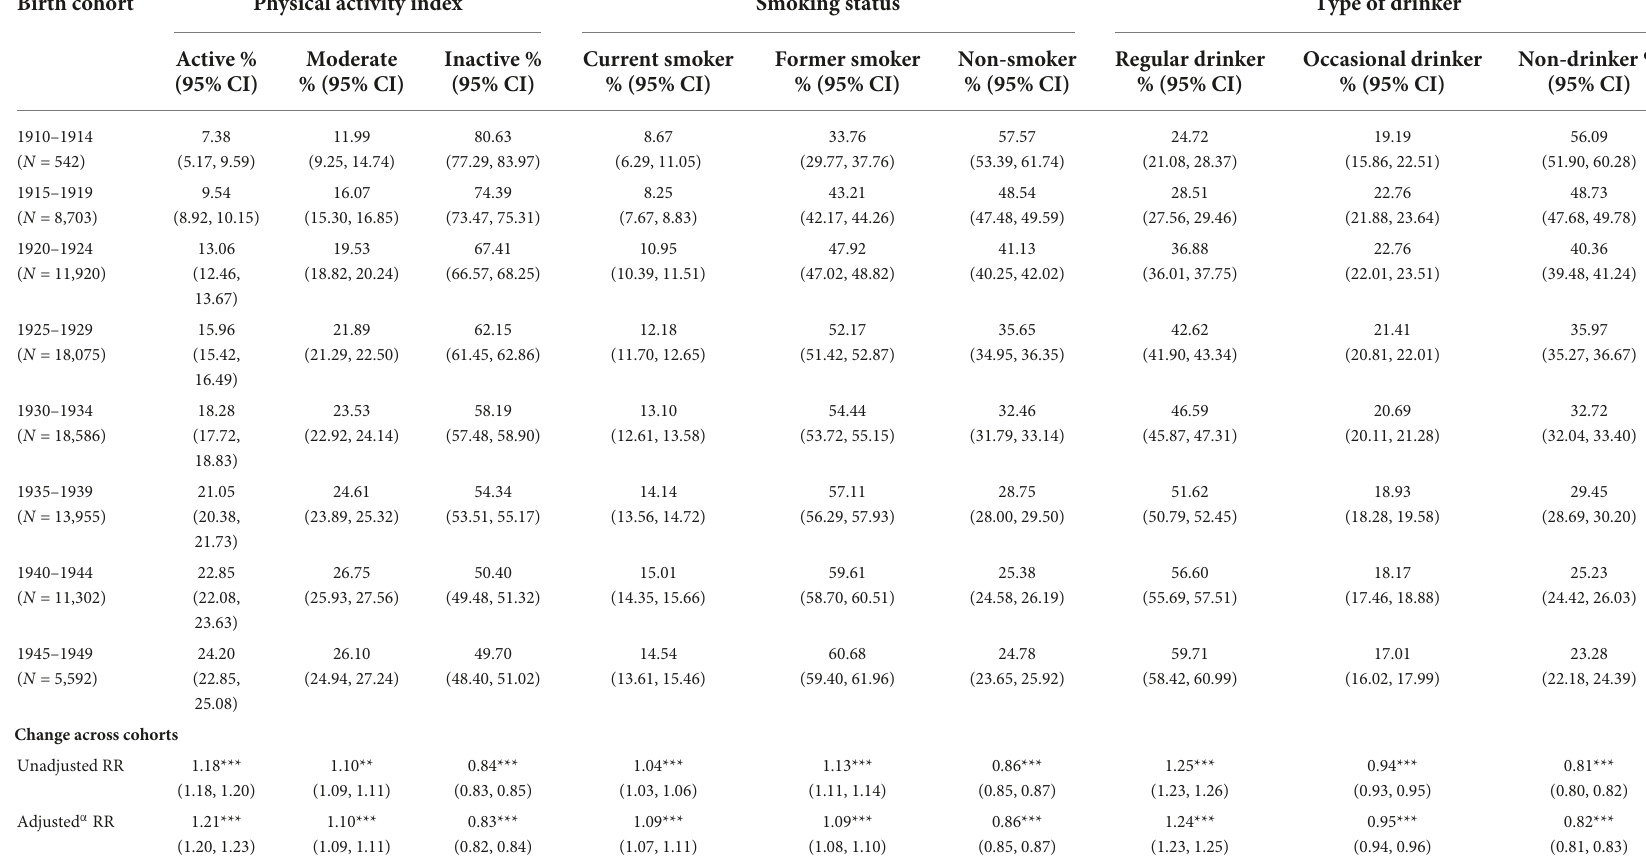
TABLE 2 Frequency of physical activity, smoking status, and type of drinker across birth cohorts for Canadian residents 65+. Birth